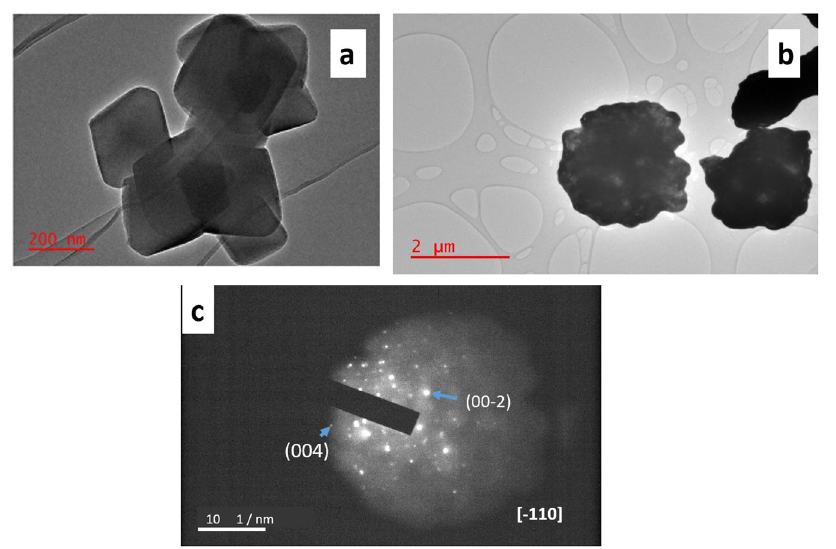
Figure 2. TEM images ( a ) MIL-125(Ti) ( b ) BiVO 4 . ( c ) SAED patterns of BiVO 4